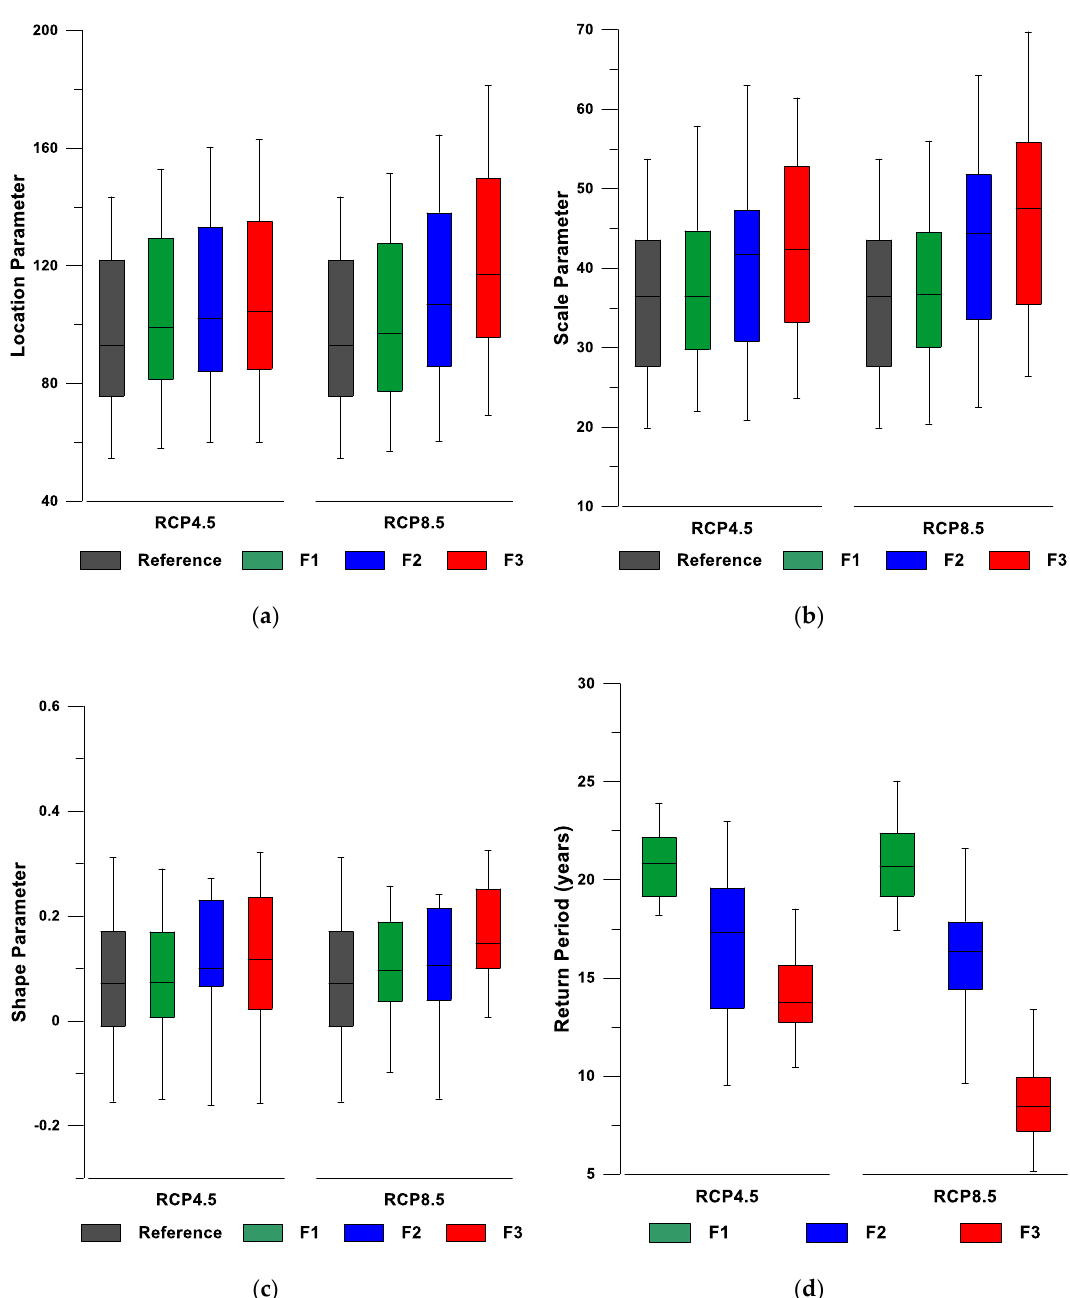
Figure 7. Box plots of ( a ) location parameter, ( b ) scale parameter, and ( c ) shape parameter of generalized extreme value (GEV) distribution for CMIP5 precipitation, and ( d ) future change in 20-year precipitation of reference climate.